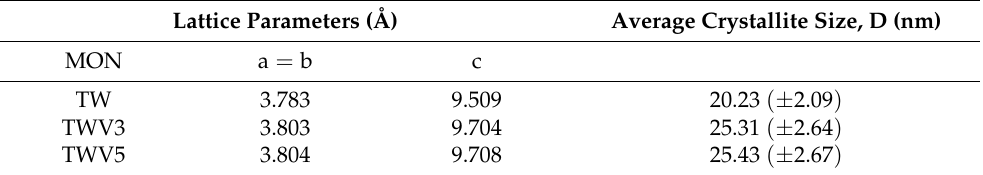
Table 1. Lattice constants and crystallite size of titanium dioxide in TW , TWV3, and TWV5 MON .